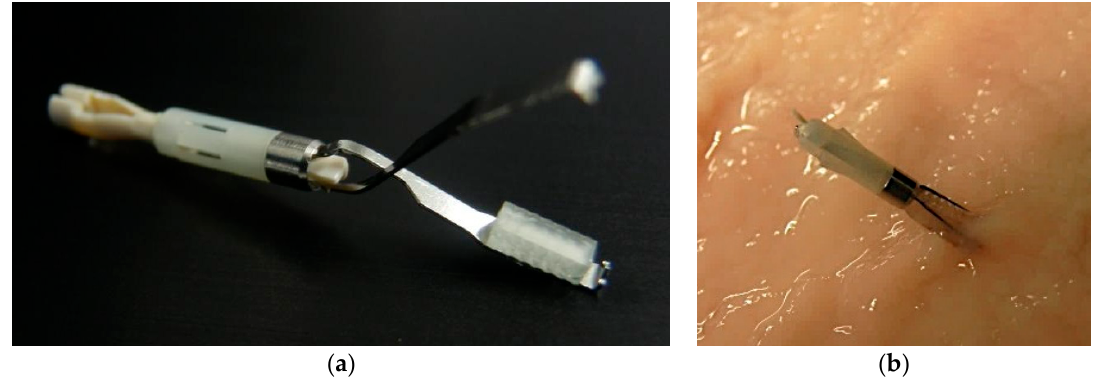
Figure 3. Photographs of ( a ) the fluorescent clip with glass phosphor at the tip and ( b ) a glass phosphor-attached clip fixed to the stomach mucosa.